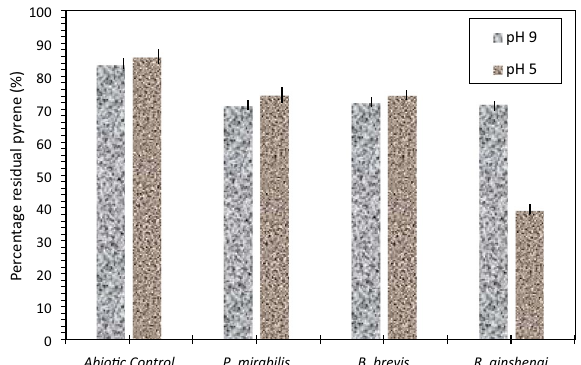
Figure 11. Residual pyrene in culture for the 3 strains at pH 5.0 and pH 9.0 after 18 days, vertical bar represents error